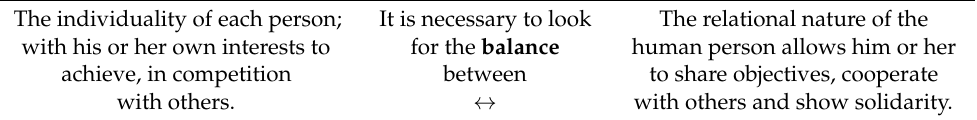
Table 3. Anthropology of the